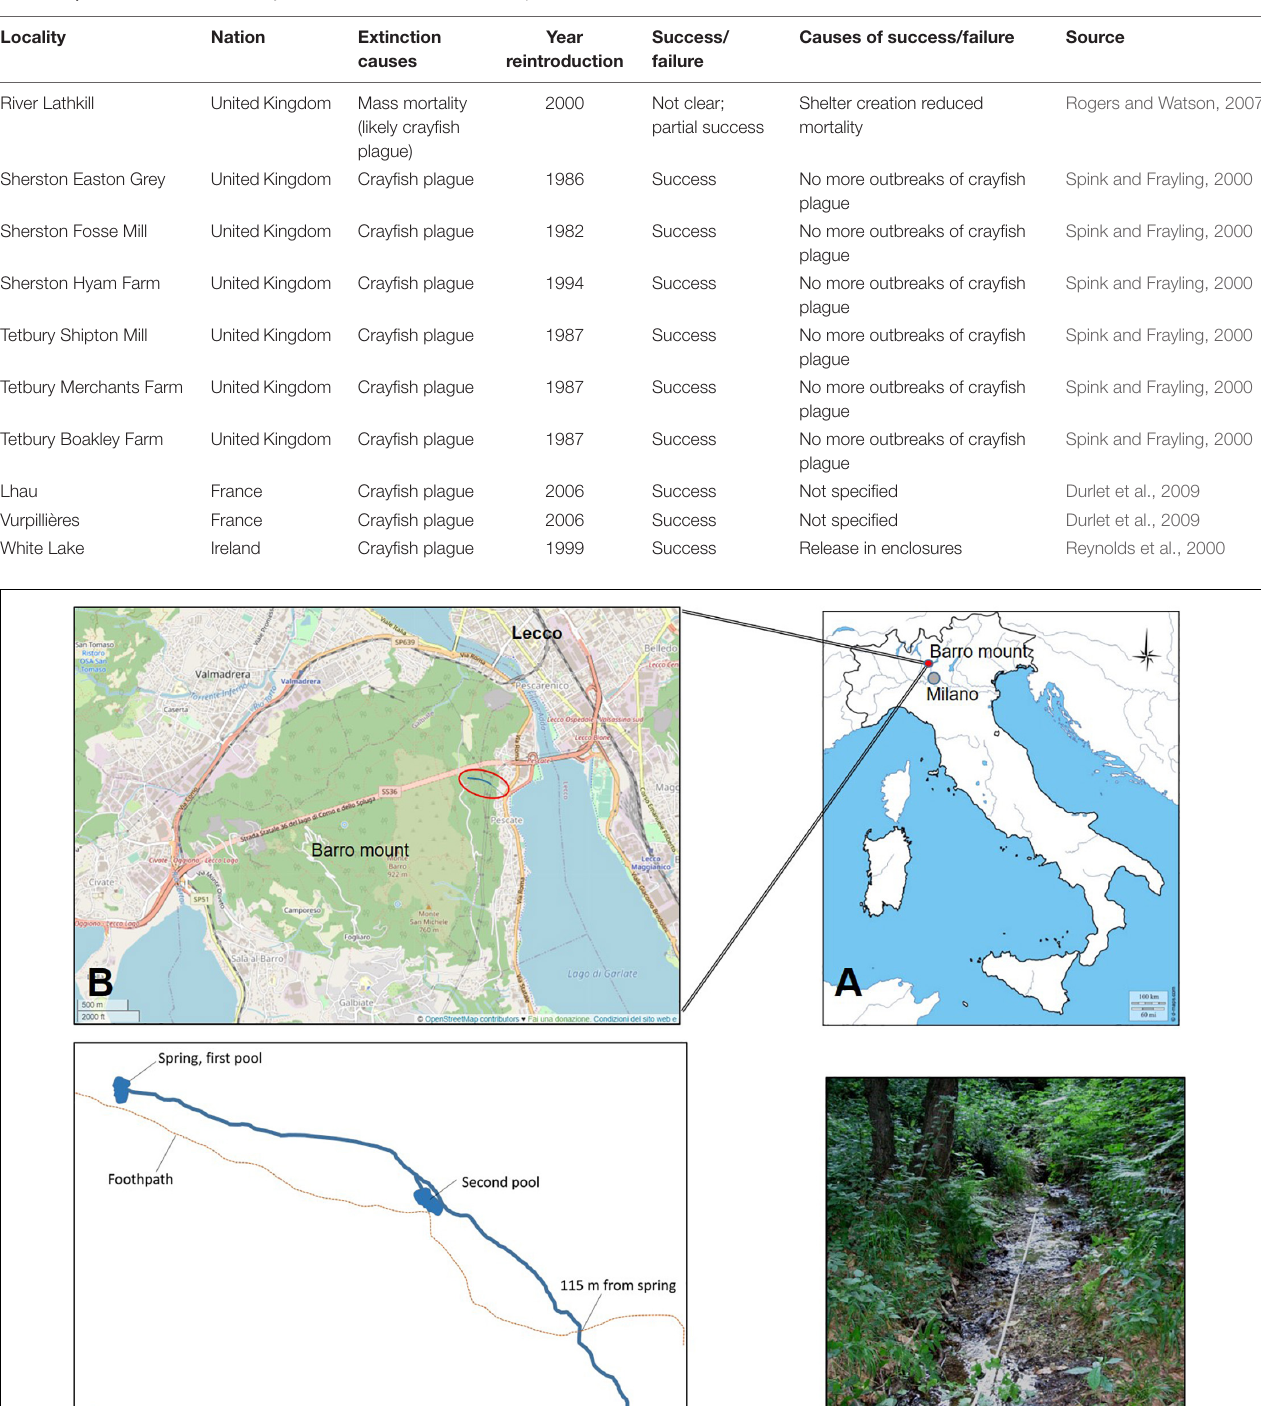
TABLE 1 | Sites of white-clawed crayfish reintroductions described in peer-reviewed studies. Locality